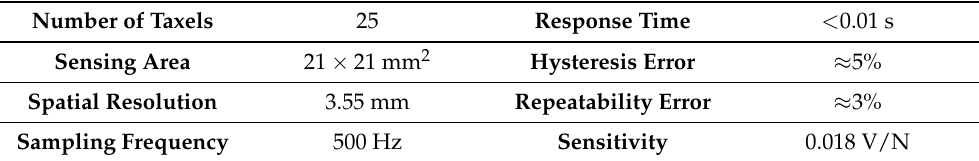
Table 1. Characteristics of the tactile